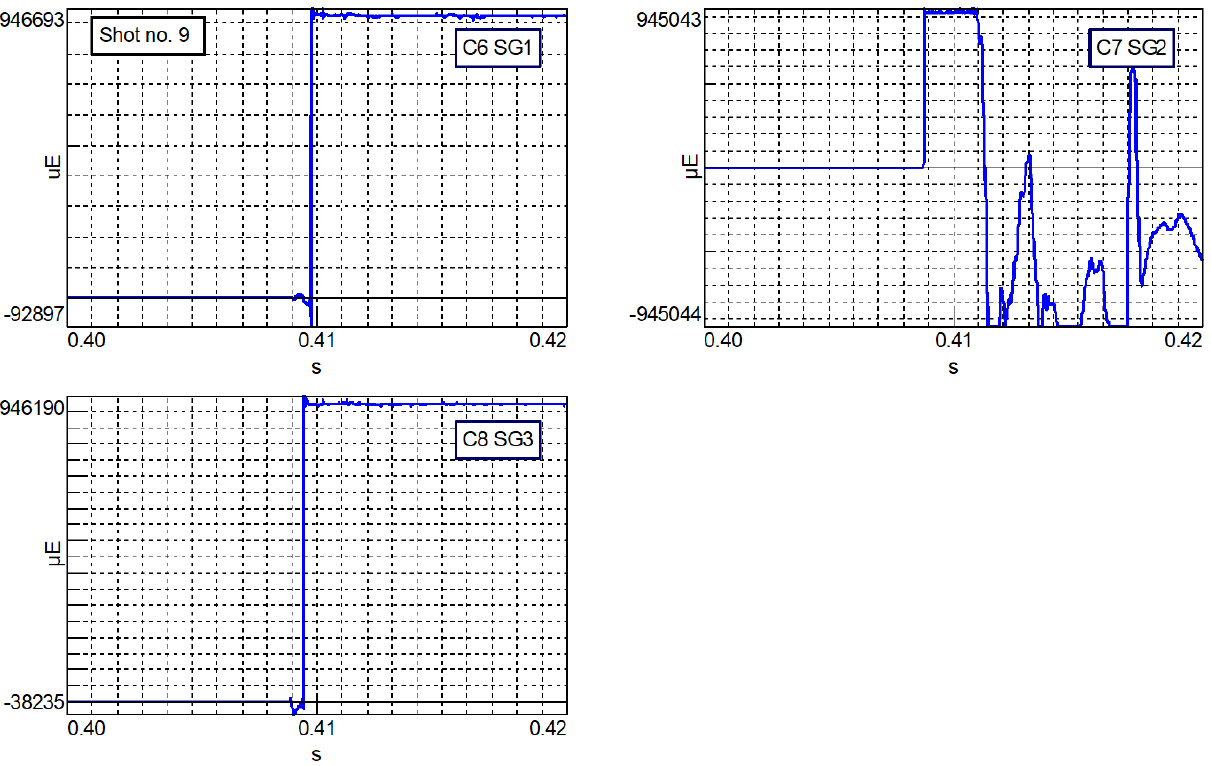
Figure 20. Strains recorded by 3 tensiometers (shot no. 9).